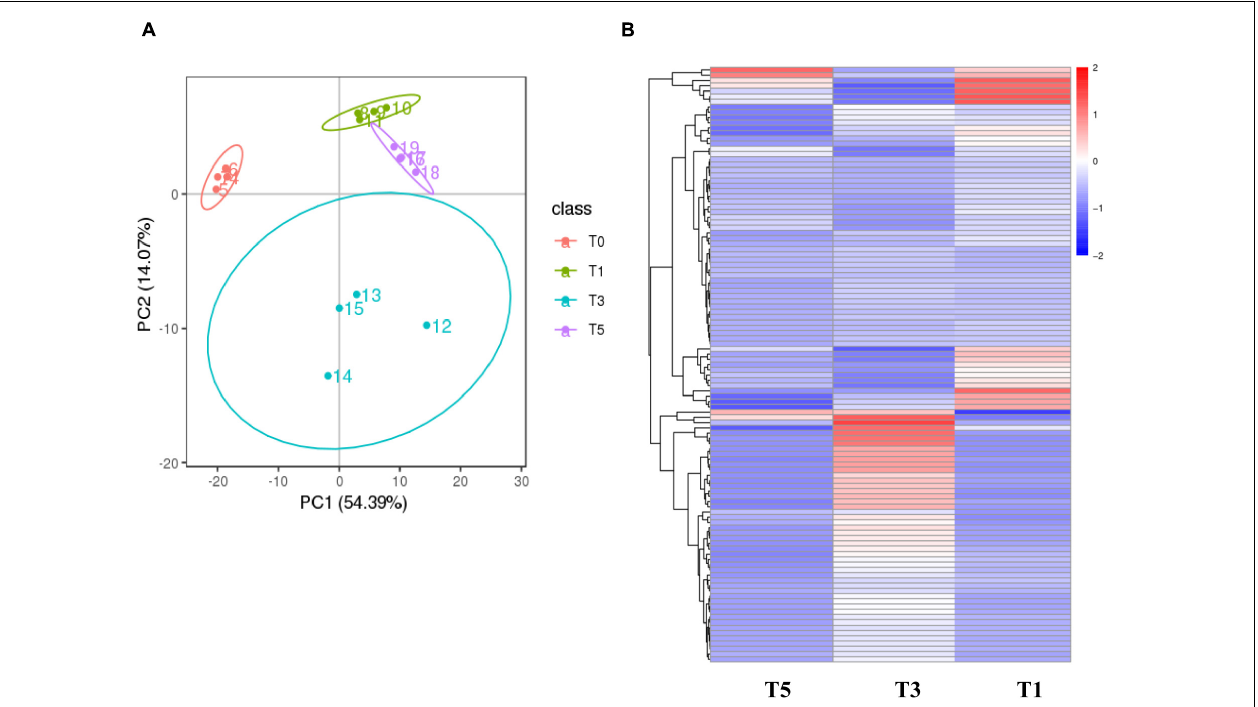
FIGURE 2 | Metabolic profiling results of the monocropping groups (T3 and T5) and control group (T1). (A) PLS-DA score plot; (B) hierarchical clustering analysis (HCA) for the metabolites based on their z-normalized abundances. T3: 3 years of monocropping; T5: 5 years of monocropping; T1: 1 year of cropping. PLS-DA, partial least squares discriminant